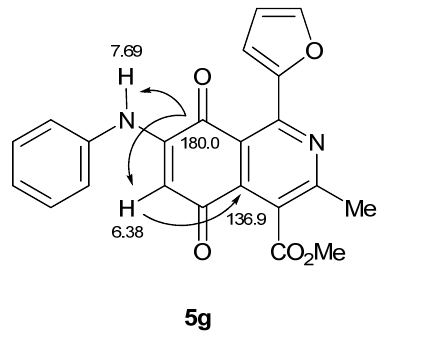
Figure 1. 3 J correlations for compounds 5g and 6a accomplished by C,H